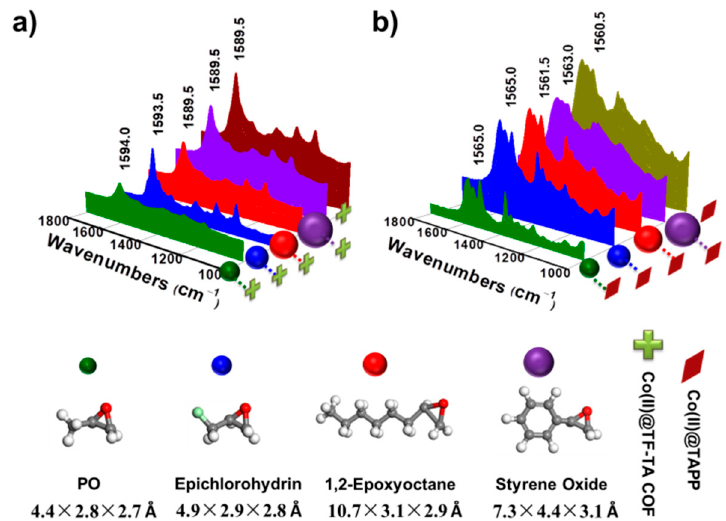
Figure 3. Raman spectra patterns of ( a ) Co(II)@TAPP and their epoxide complexes and ( b ) Co(II)@TF-TA COF and their epoxide complexes. The dimensions of epoxides are determined using MOPAC 7.